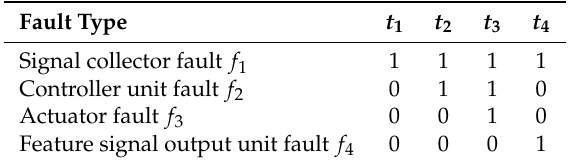
Table 1. Fault-test dependency matrix of the control system.